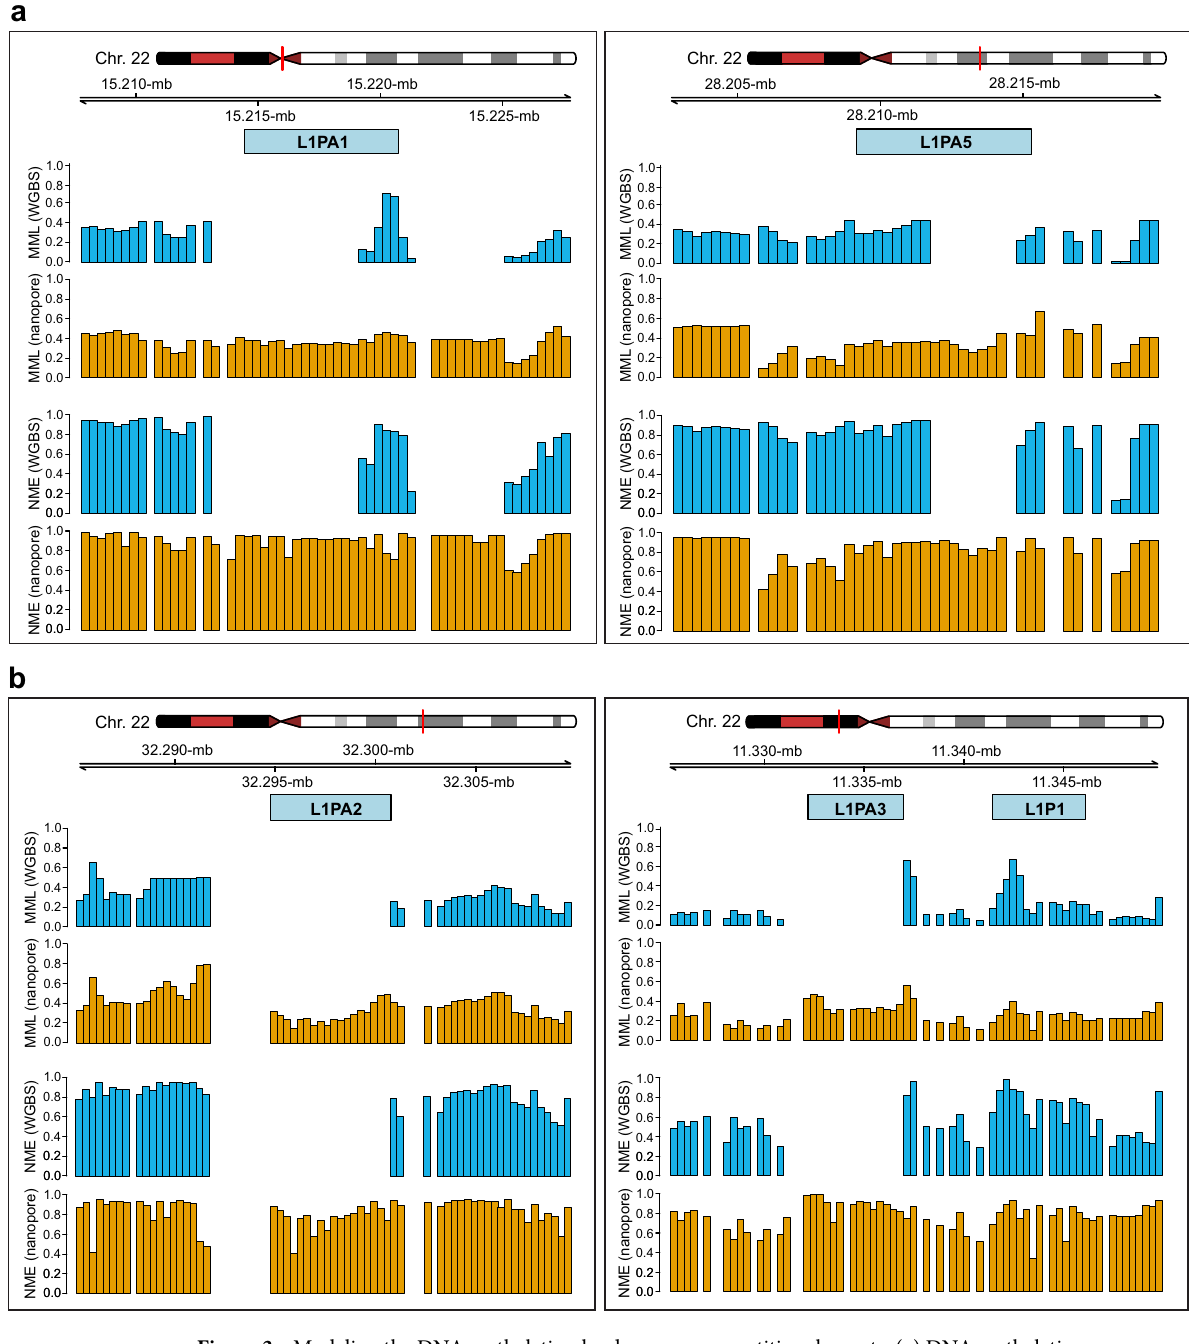
Figure 3. Modeling the DNA methylation landscape over repetitive elements. ( a ) DNA methylation over the L1PA1 and L1PA5 subfamilies of the LINE-1 family of TEs is only partially modeled using WGBS data (GSM2308632) associated with the human Utah/Ceph lymphoblastoid cell line. ( b ) Methylation over the L1PA2 and L1PA3 subfamilies is not modeled using the WGBS data. However, DNA methylation is successfully modeled by CpelNano using the corresponding nanopore data